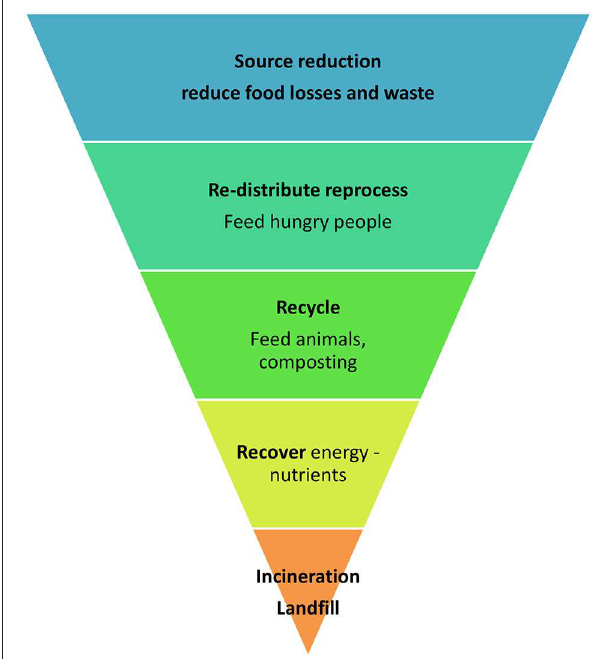
FIGURE 1 | The food recovery hierarchy. From upper most desirable source reduction to the least desirable at the bottom—landfill.